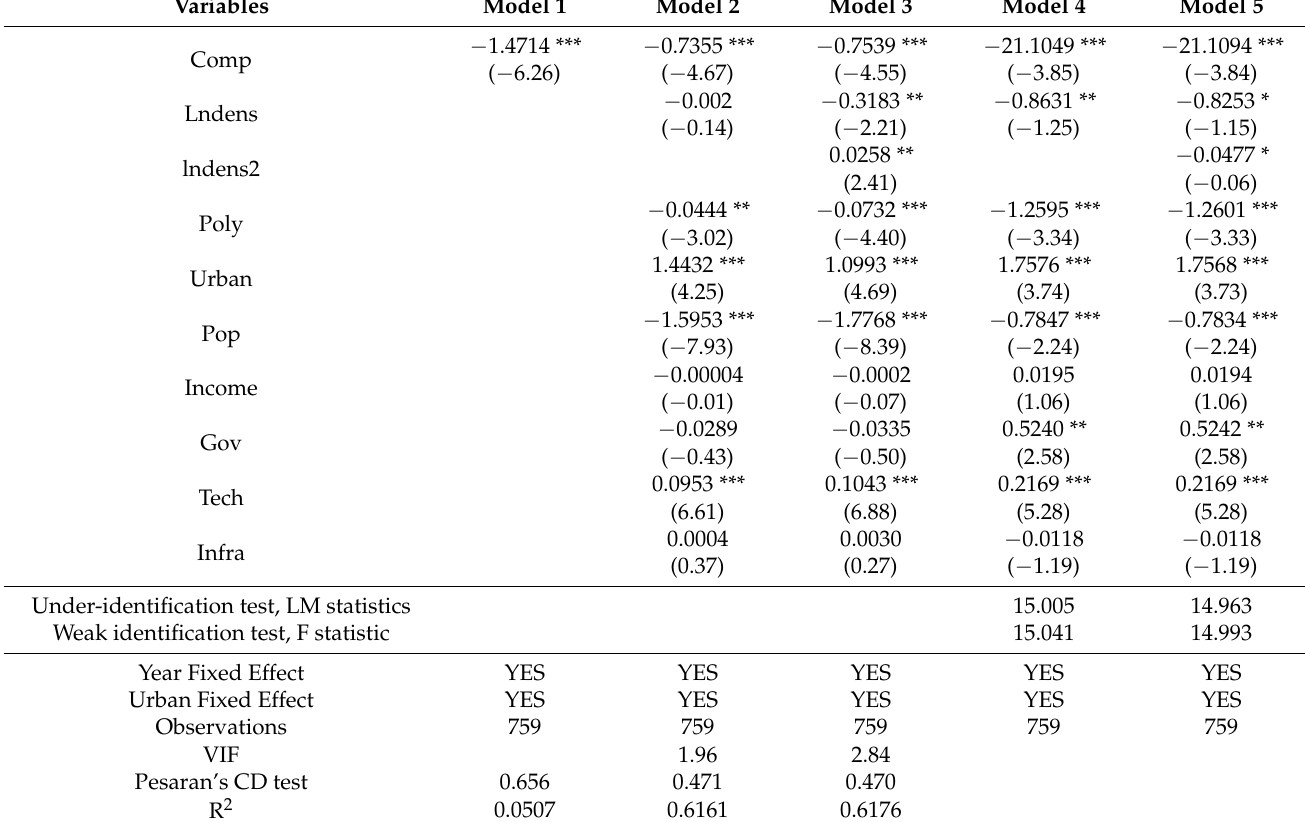
Table 3. Baseline regression